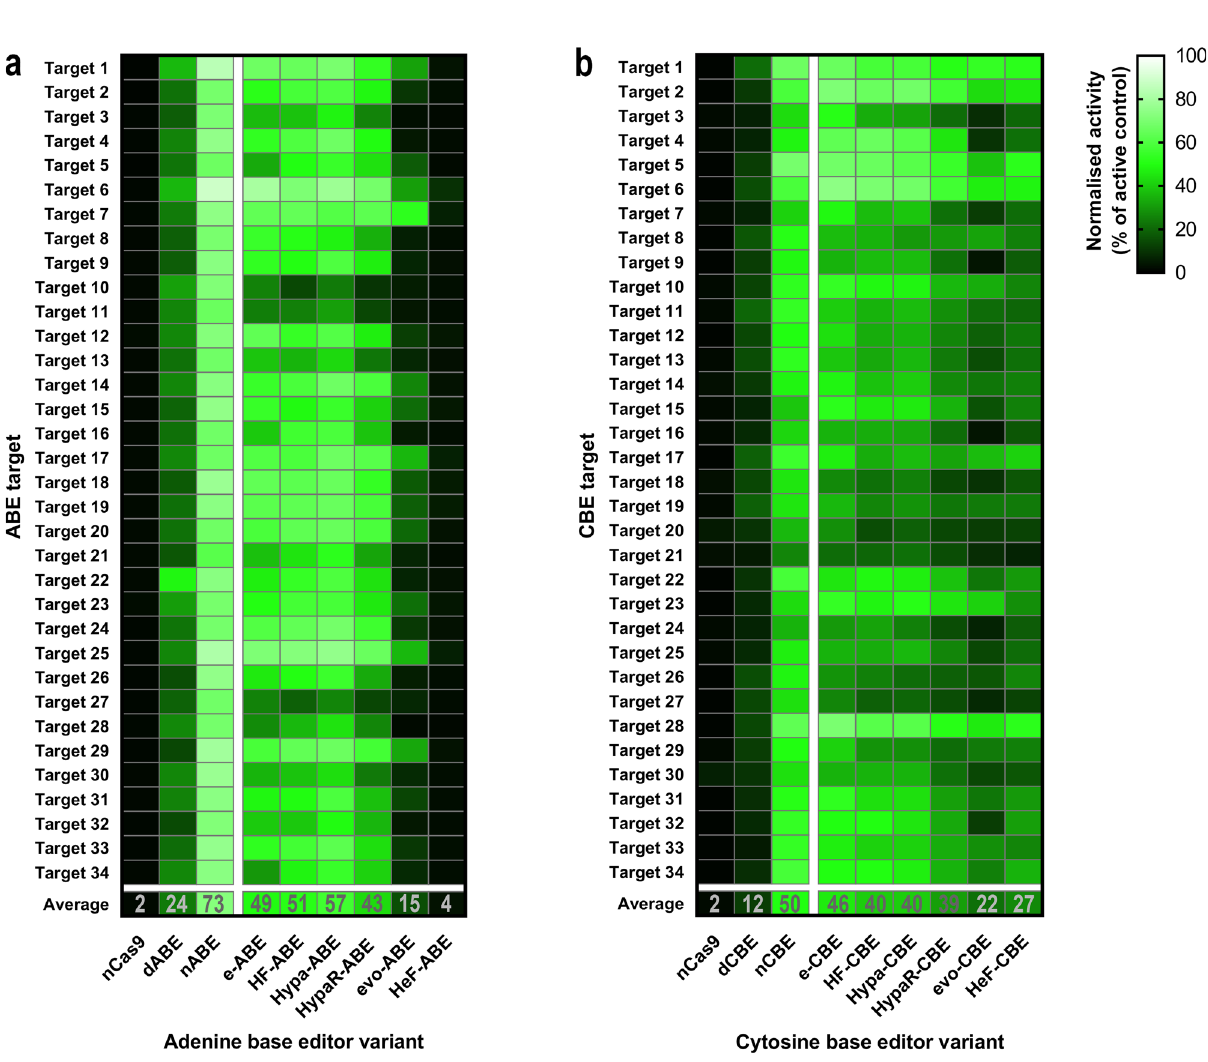
Fig. 5 On-target activities of various increased fi delity ABE and CBE variants on 34 target sites. a , b The heatmap shows the mean on-target activity deriving from three parallel transfections normalised to the active splice donor site plasmid. A total of 34 target sequences, differing in their PAM proximal 10 nucleotides, were used to test dABE, nABE and 6 increased fi delity ABEs ( a ) as well as dCBE, nCBE and 6 increased fi delity CBEs ( b ) as indicated in the fi gure. As a negative control, nCas9 was used with all 34 targets. For source data see the Source Data fi